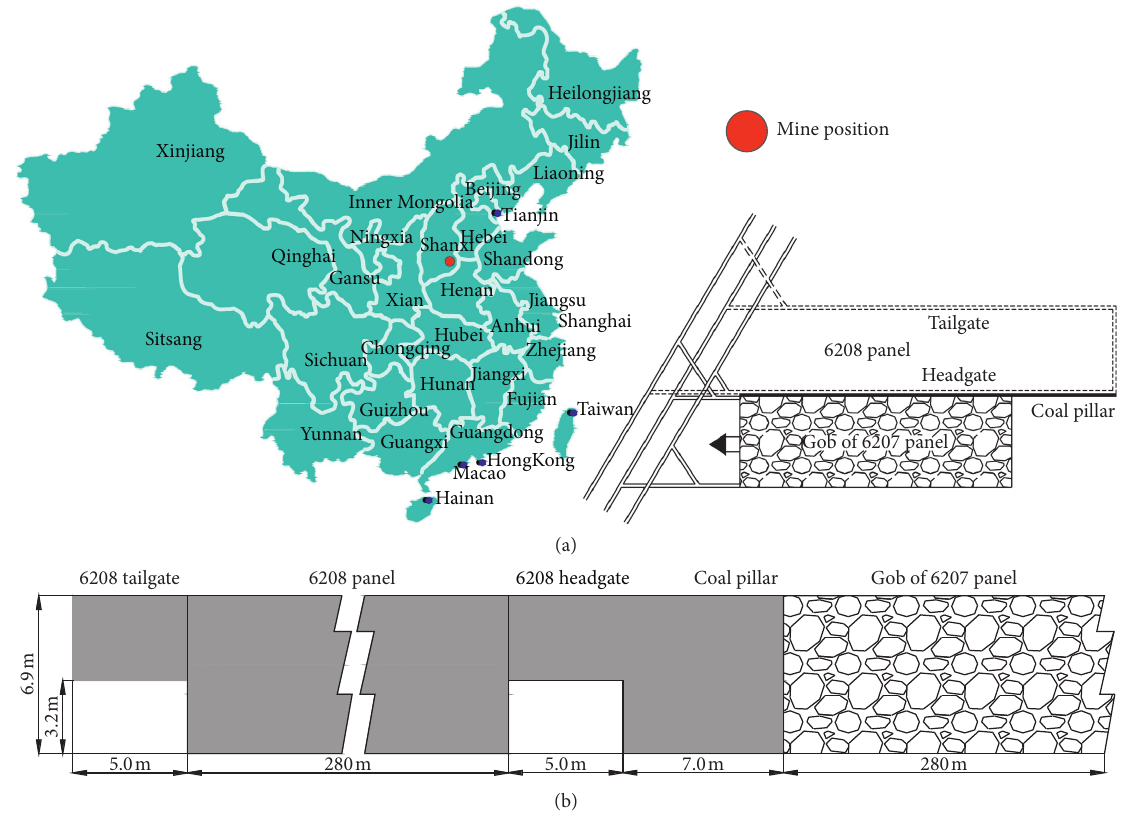
Figure 8: The panel introduction of sampling site: (a) mine position and plan view and (b) section